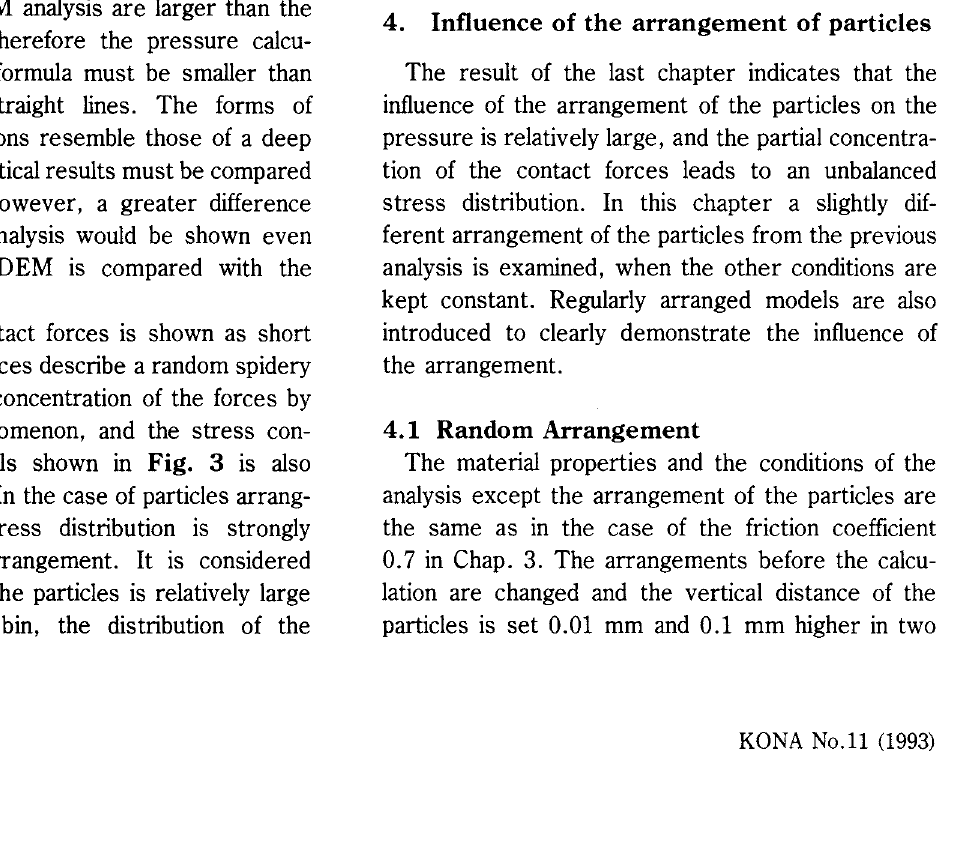
Pressure towards bottom in static state (comparison of friction coefficients) which shows the calculated pressure exerted by the weight of all the particles. The pressures to wards the bottom are lower near the side walls, and this tendency is similar to that in practical or experimental conditions.